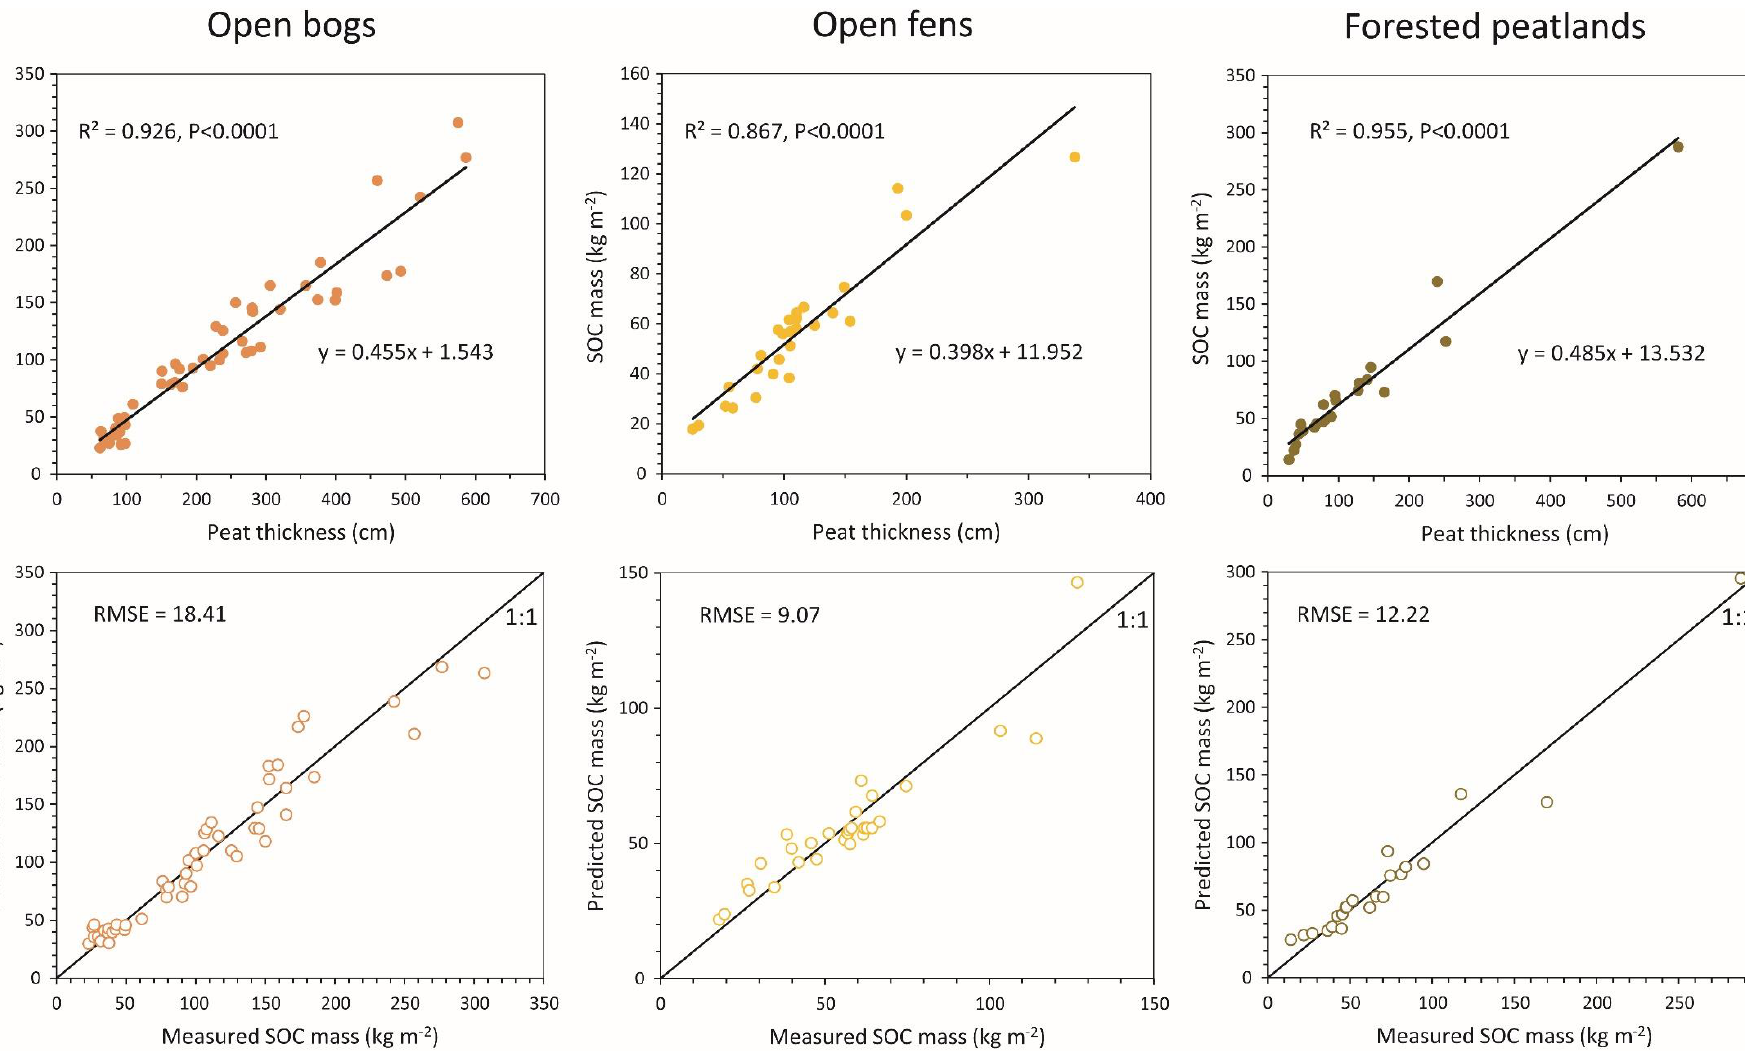
Figure 4. Relationship between peat thickness and SOC mass (upper panels) and measured against predicted SOC mass values in the three subclasses of peatlands (lower panels). RMSE : root mean square